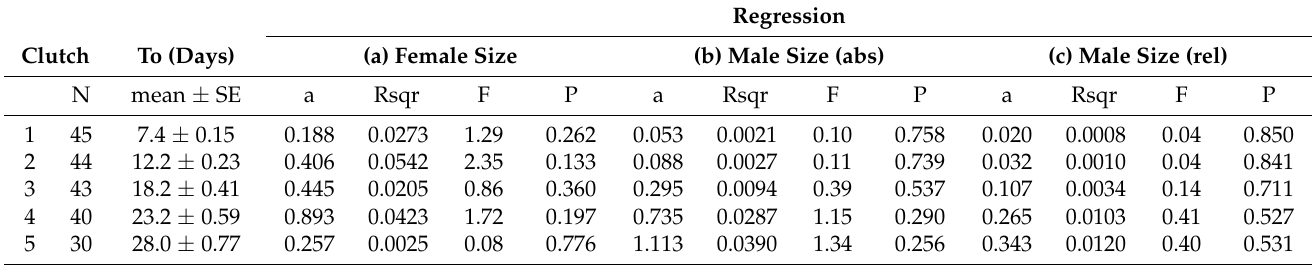
Table 4. Relationship between body size and the time elapsed to deposition of the first five clutches, experiment 2022. Clutch: clutch order, N: number of clutches. To (days): the time elapsed from the transfer to laboratory conditions to deposition of the clutch (days). Regression: (a): Female size: regression of To on female body length (mm). (b) Male size (abs): regression of residuals of regression (a) on “absolute male size” which is male body length (mm). (c) Male size (rel): regression of residuals of regression (a) on “relative male size” which is the difference between the male and female body length (mm). a: slope of regression line, Rsqr: coefficient of determination of regression line, F: F statistics of ANOVA test, P: P value of ANOVA